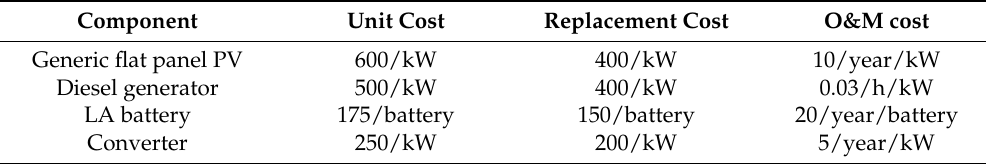
Table 2. Equipment initial cost * [28].